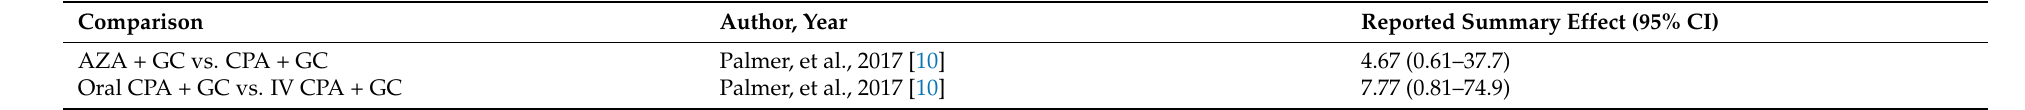
Table 17. Malignancy during treatment of lupus nephritis (Network